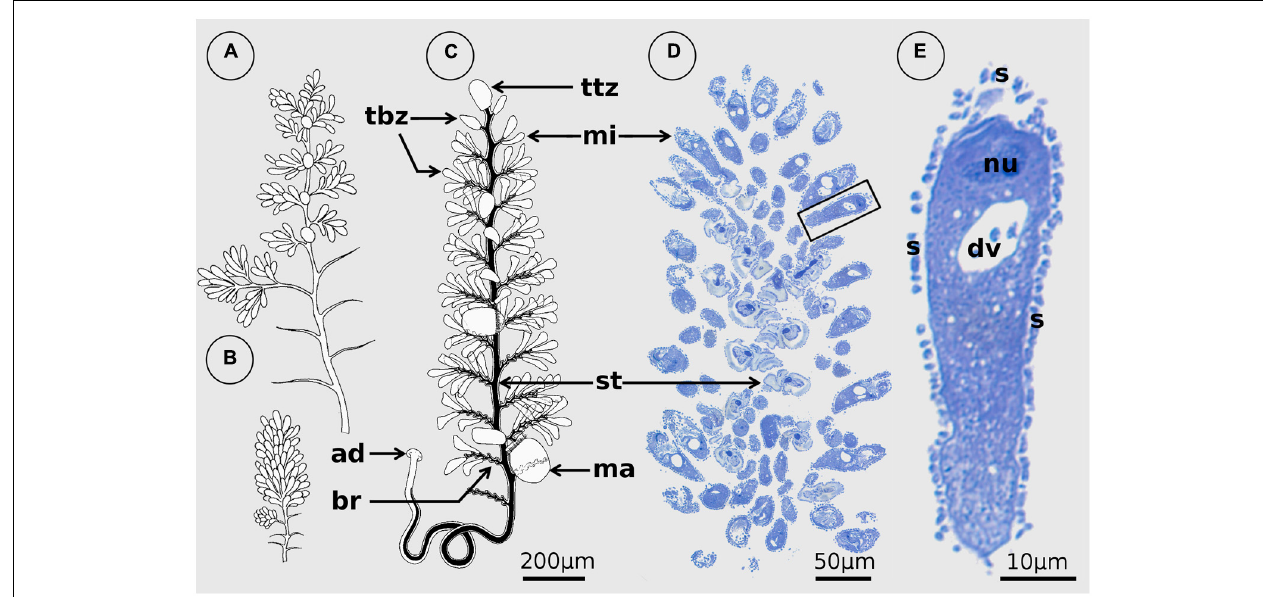
FIGURE 1 | Zoothamnium niveum. (A,B) Original illustrations modified from Hemprich and Ehrenberg (1829) showing the same colony expanded (A) and contracted (B) . (C) Drawing of a colony from the redescription of Z. niveum showing the different cell types: the macrozooid (ma), the microzooid (mi), the terminal branch zooids (tbz), and the terminal top zooid (ttz; modified